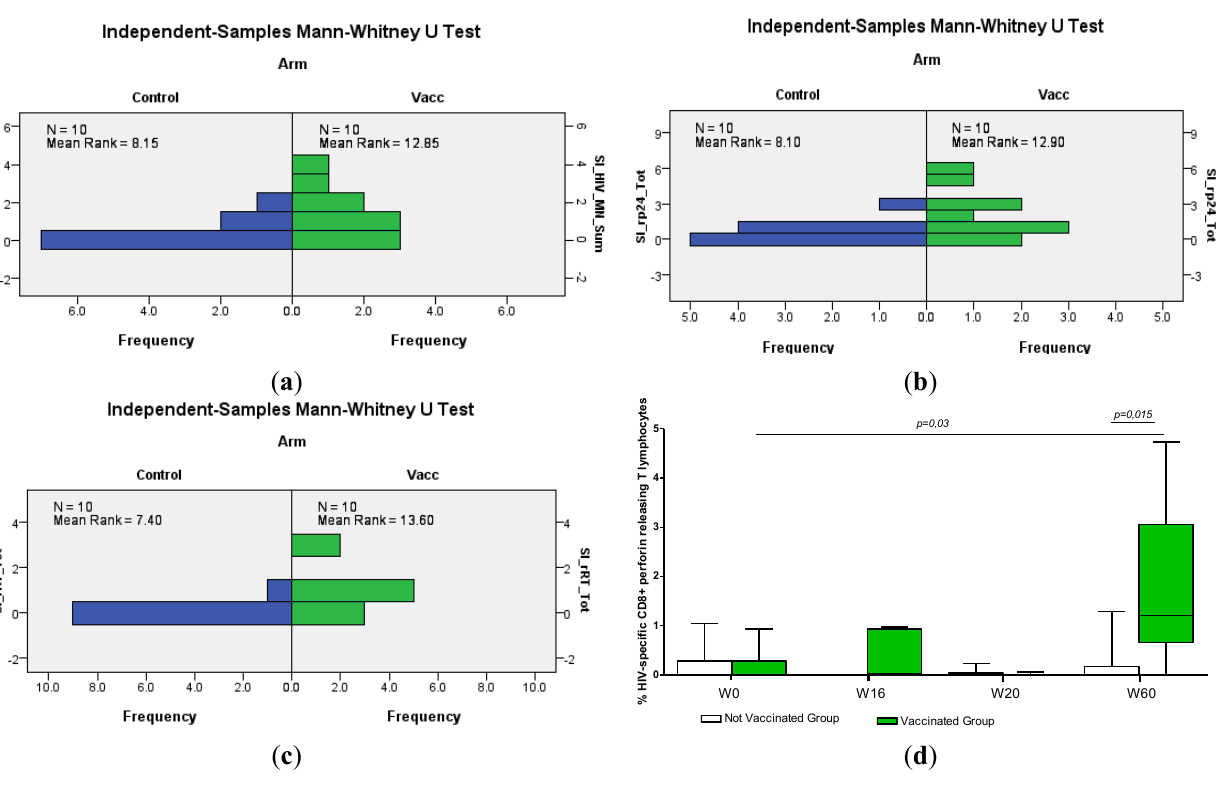
Figure 1. Lymphocyte proliferation assays of the paediatric cohort, showing responses to ( a ) the HIV-1 MN antigen; ( b ) the p24 antigen; ( c ) the RT antigen (summarized, sum or total, for Weeks 12–72); ( d ) the intracellular staining (ICS) data of perforin-releasing CD8+ T-cells are